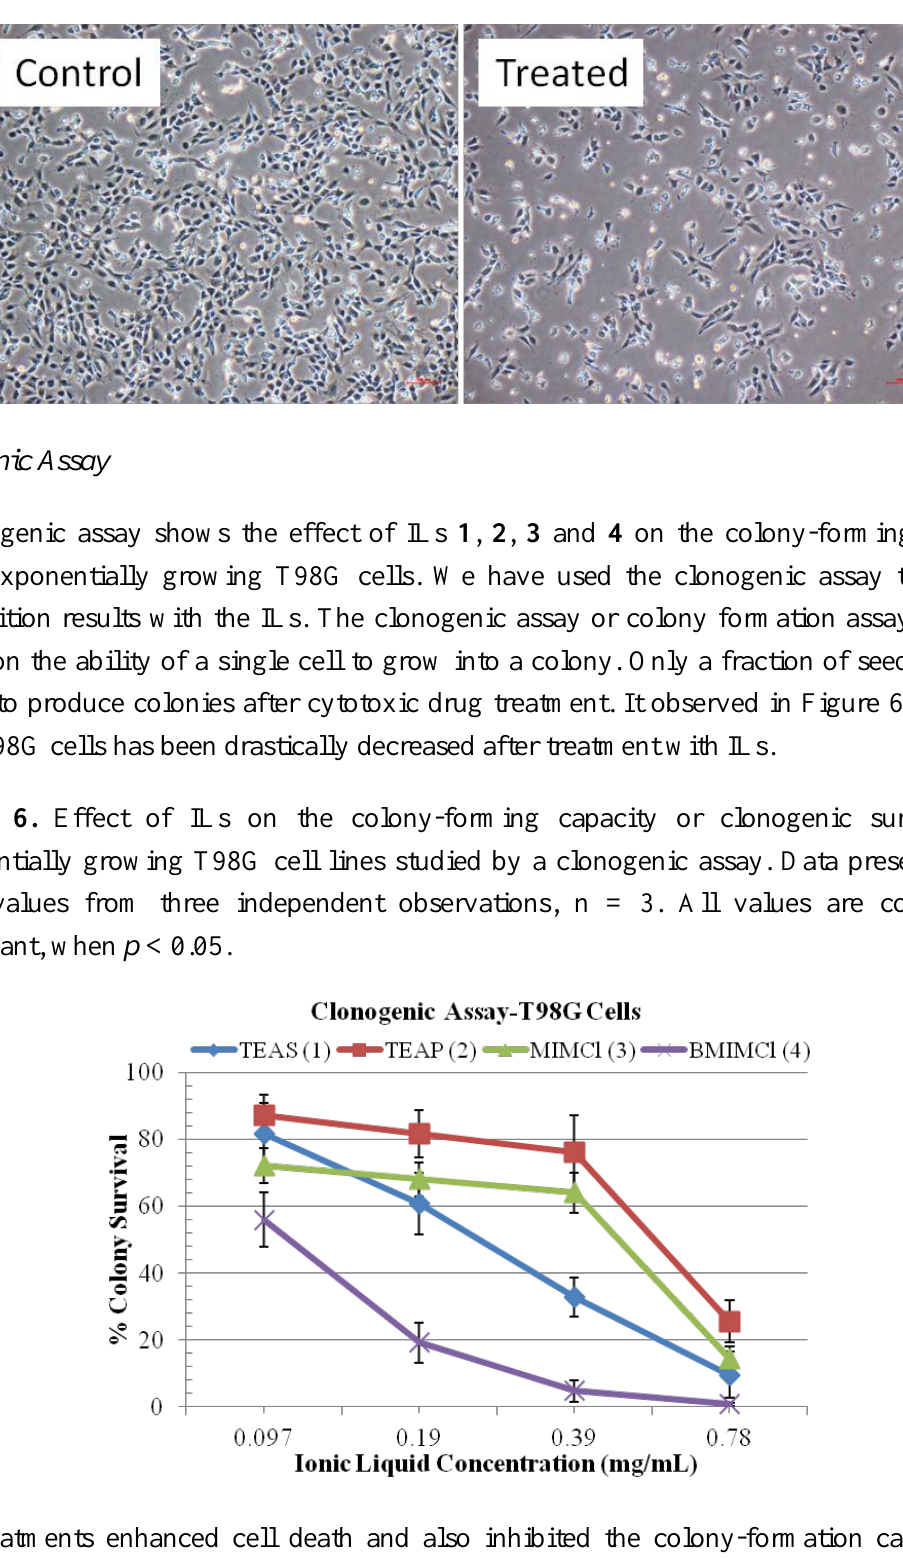
Figure 5. Morphology of T98G cells. treated with IL 4 at 0.19 mg/mL concentration after incubation for 24 h. Control is untreated cells.